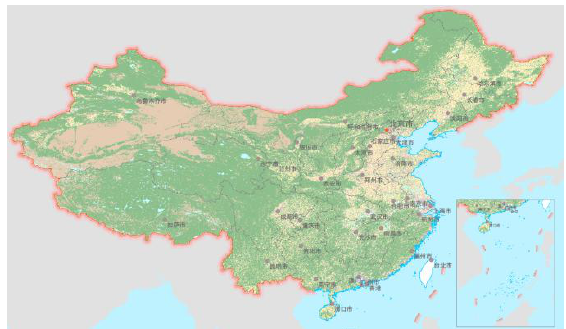
Figure 5. The national wide land cover datasets consist of 260 million vector polygon patches, with a total data amount of